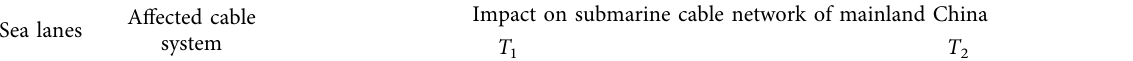
Table 7: Impact of sea lane interruption on the submarine cable network of mainland China.